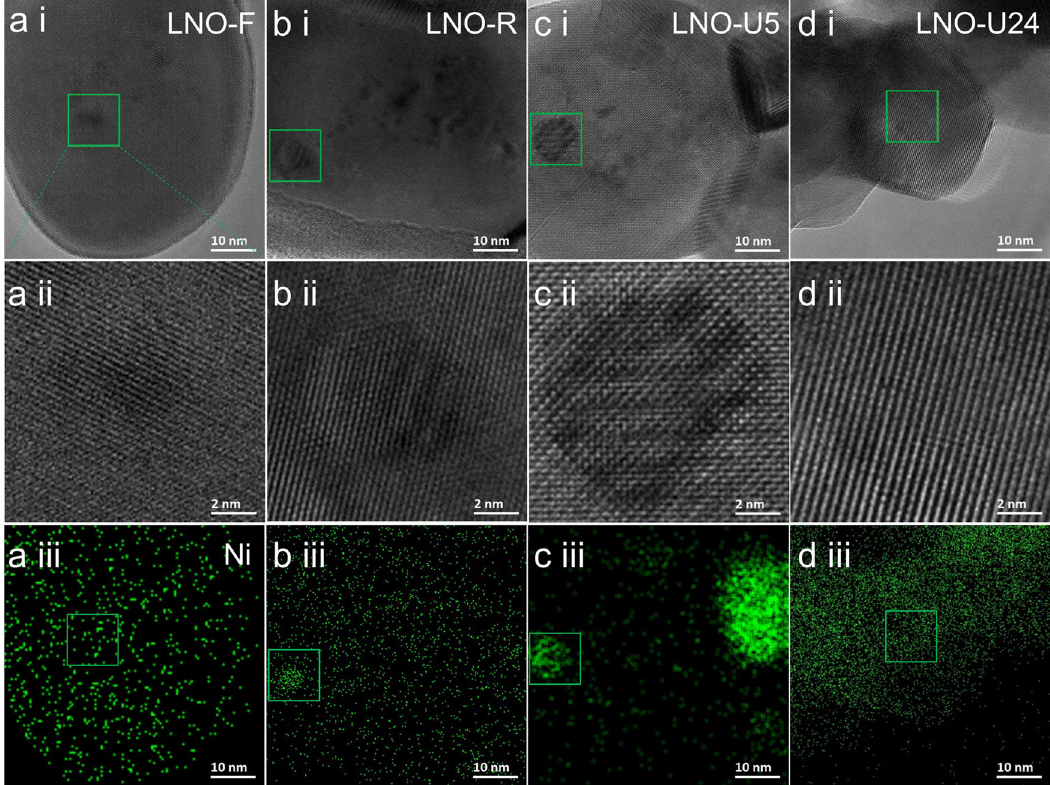
Fig. 5 HR-TEM images and EDS Mapping of Ni of LNO samples. a LNO-F, b LNO-R, c LNO-U5, and d LNO-U24 represent fresh, H 2 -reduced, used after 5 h time on stream and used after 24 h time on stream LaNi 0.1 Cr 0.9 O 3 samples, respectively. The 1st row: HR-TEM images, the 2nd row: magni fi ed HR-TEM images corresponding to the green squares in the 1st row, and the 3rd row: EDS Mapping of Ni corresponding to the HR-TEM images in the 1st row. The regions marked by green squares in ( b , c ) are